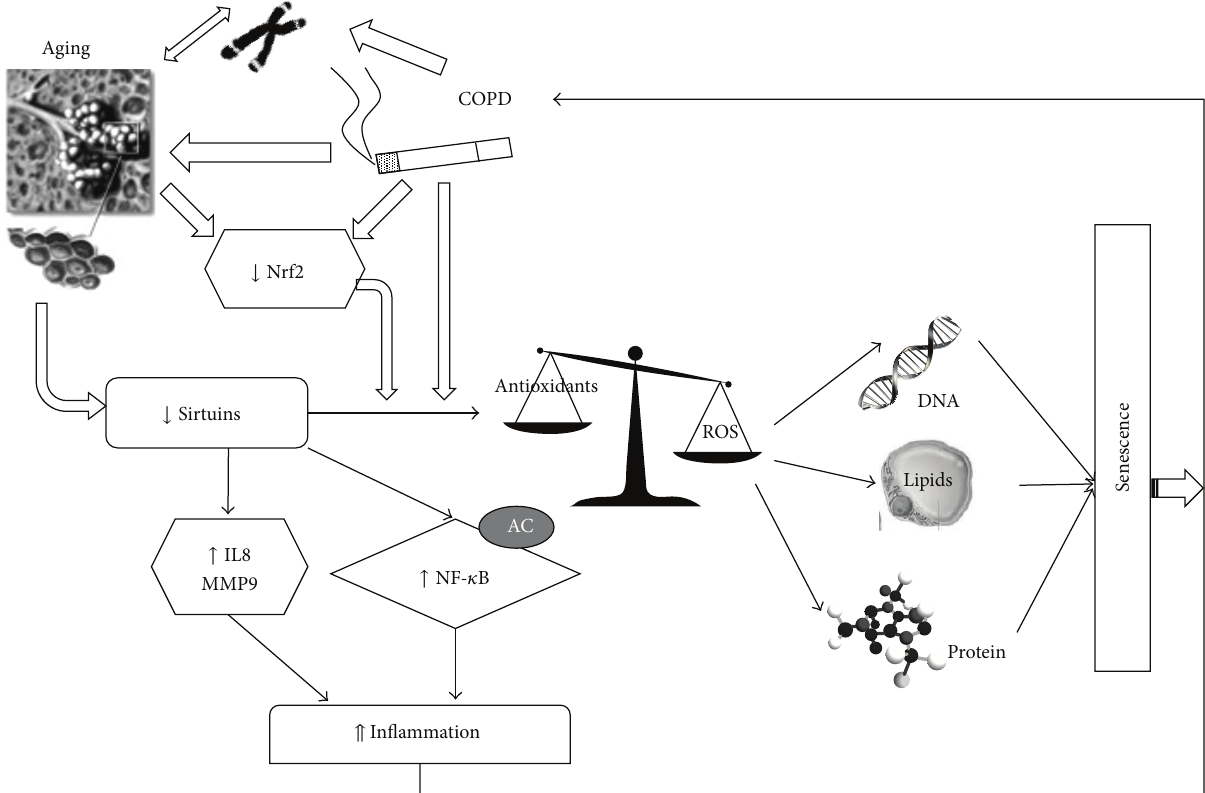
Figure 1: “The aging theory of COPD.” Several molecules involved in aging are also implicated in COPD pathogenesis: mutations in TERT are responsible for telomeres shortening; decreased Nrf2 can explain the excessive oxidative stress that causes damage and inflammation during both aging and COPD. Recent studies have suggested a crucial role of SIRT1 in COPD. Aging of lung is characterized by reduction in SIRT1 activity and expression. Decreased levels of SIRT1 lead to increased acetylation of NF- 𝜅 B and are responsible for a persistent activation of proinflammatory molecules, such as IL8 and MMP9, and also for raised levels of senescence through accumulation of oxidants at cellular constituents (DNA, lipid, and protein). At the same time, COPD and smoking habit are associated with decreased SIRT1 activity and consequently increased inflammation and senescence. Finally, a vicious circle occurs with inflammation and senescence that further deteriorate COPD and aging